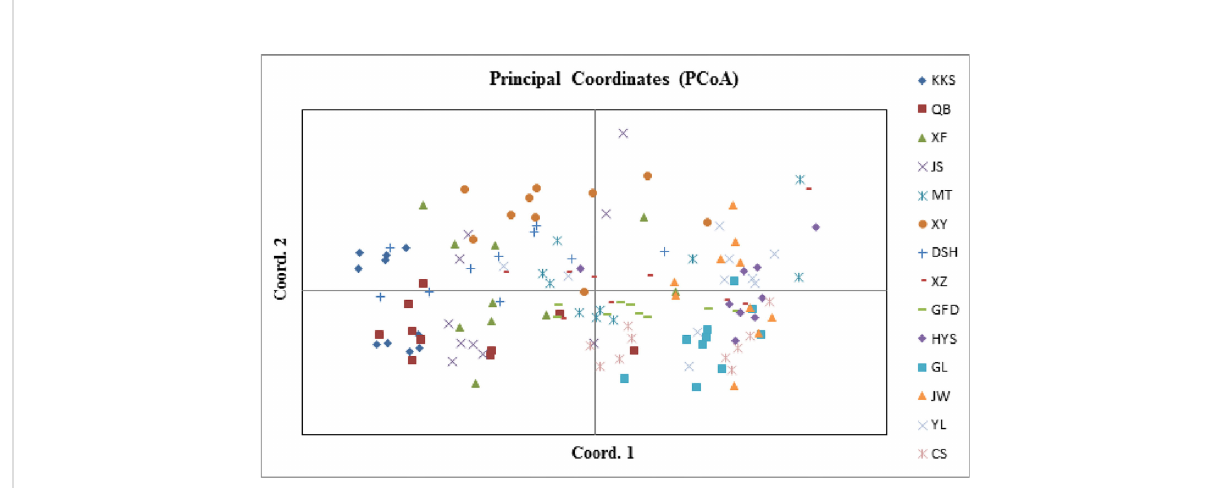
FIGURE 7 Principal coordinates analysis of Ch. utilis individuals.